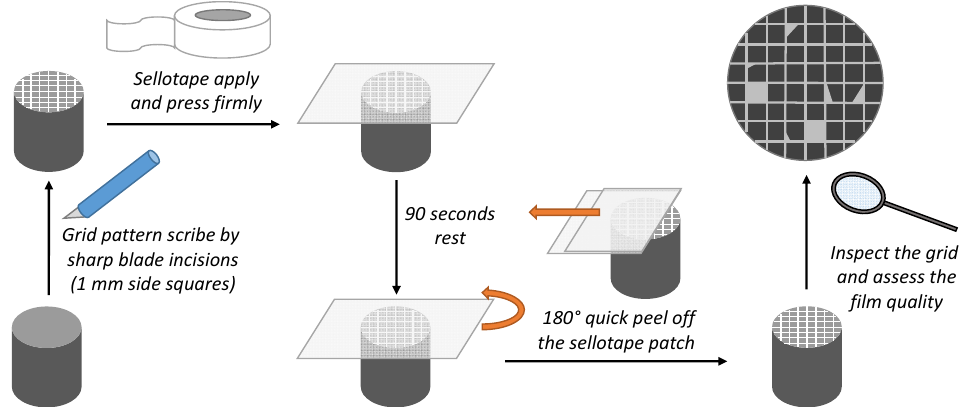
Scheme 1. Schematic diagram of the electrodeposition process (Ref. = SCE reference electrode, WE = OLC 45 working electrode, CE = platinum sheet counter electrode).